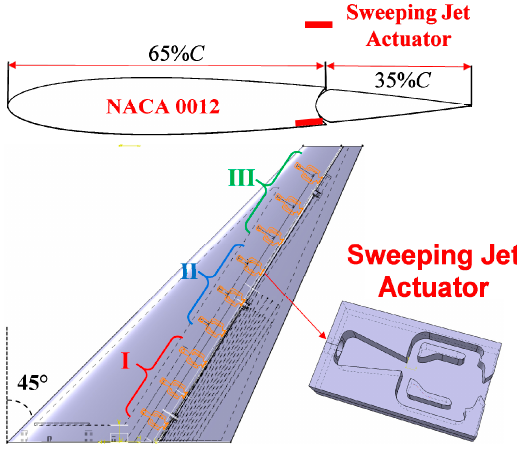
Figure 2. Vertical tail model and actuator layout diagram.